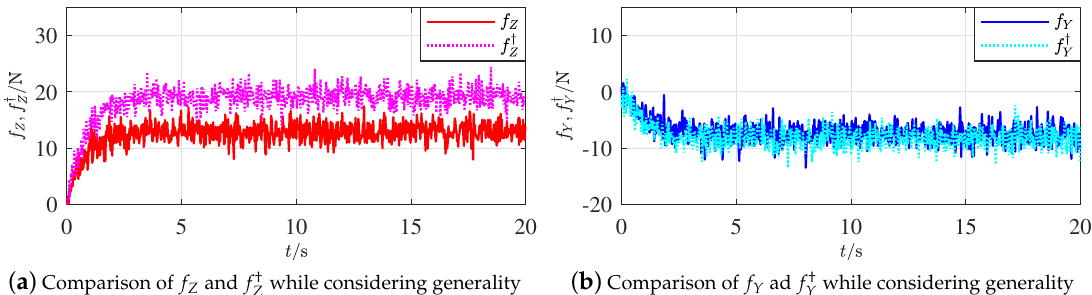
Figure 9. Comparisons of additive forces along axes z b and y b while considering